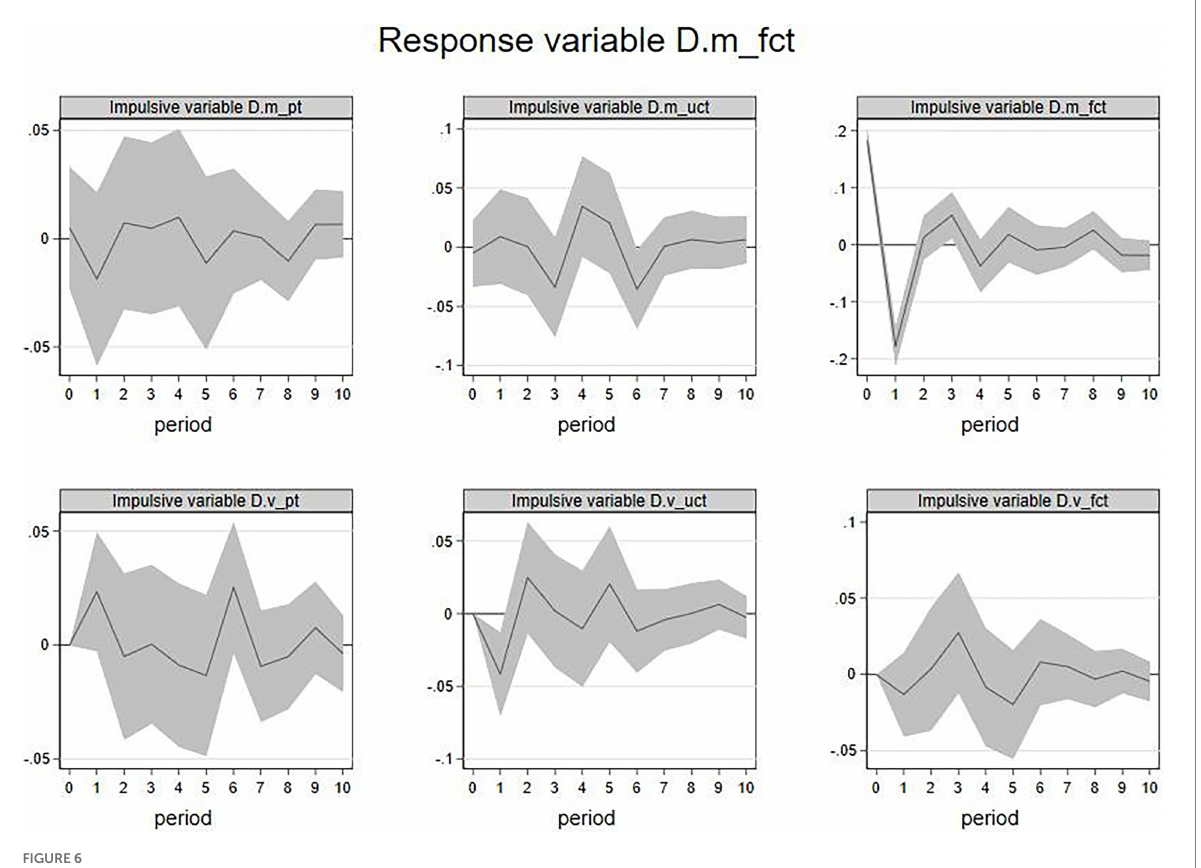
FIGURE 6 IRF: _ D.m fct (response